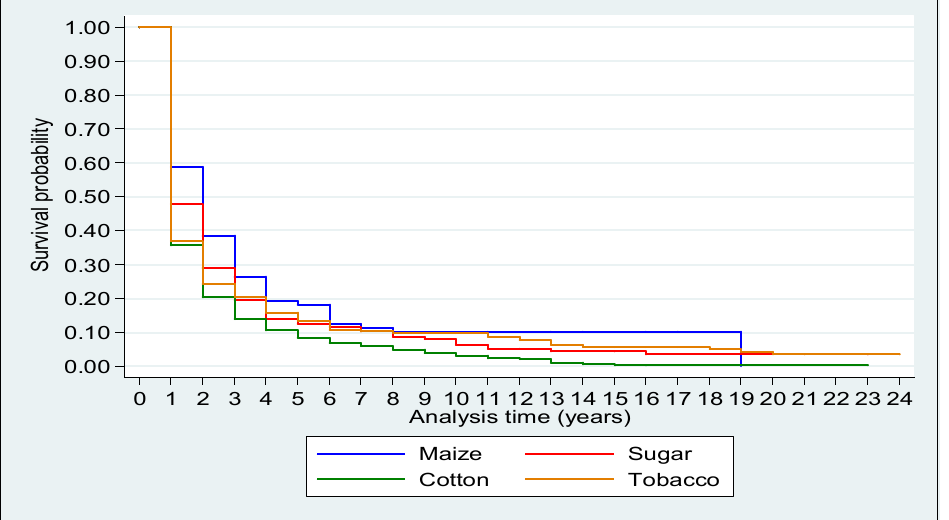
Figure 2. Export duration of agricultural products by category. Source: Author′s computation (2020).